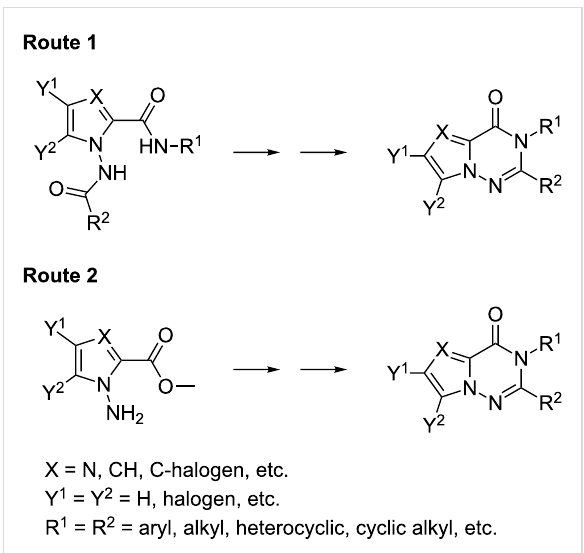
Figure 2: General synthetic routes to pyrrolotriazinones [3-6,8,9,11].